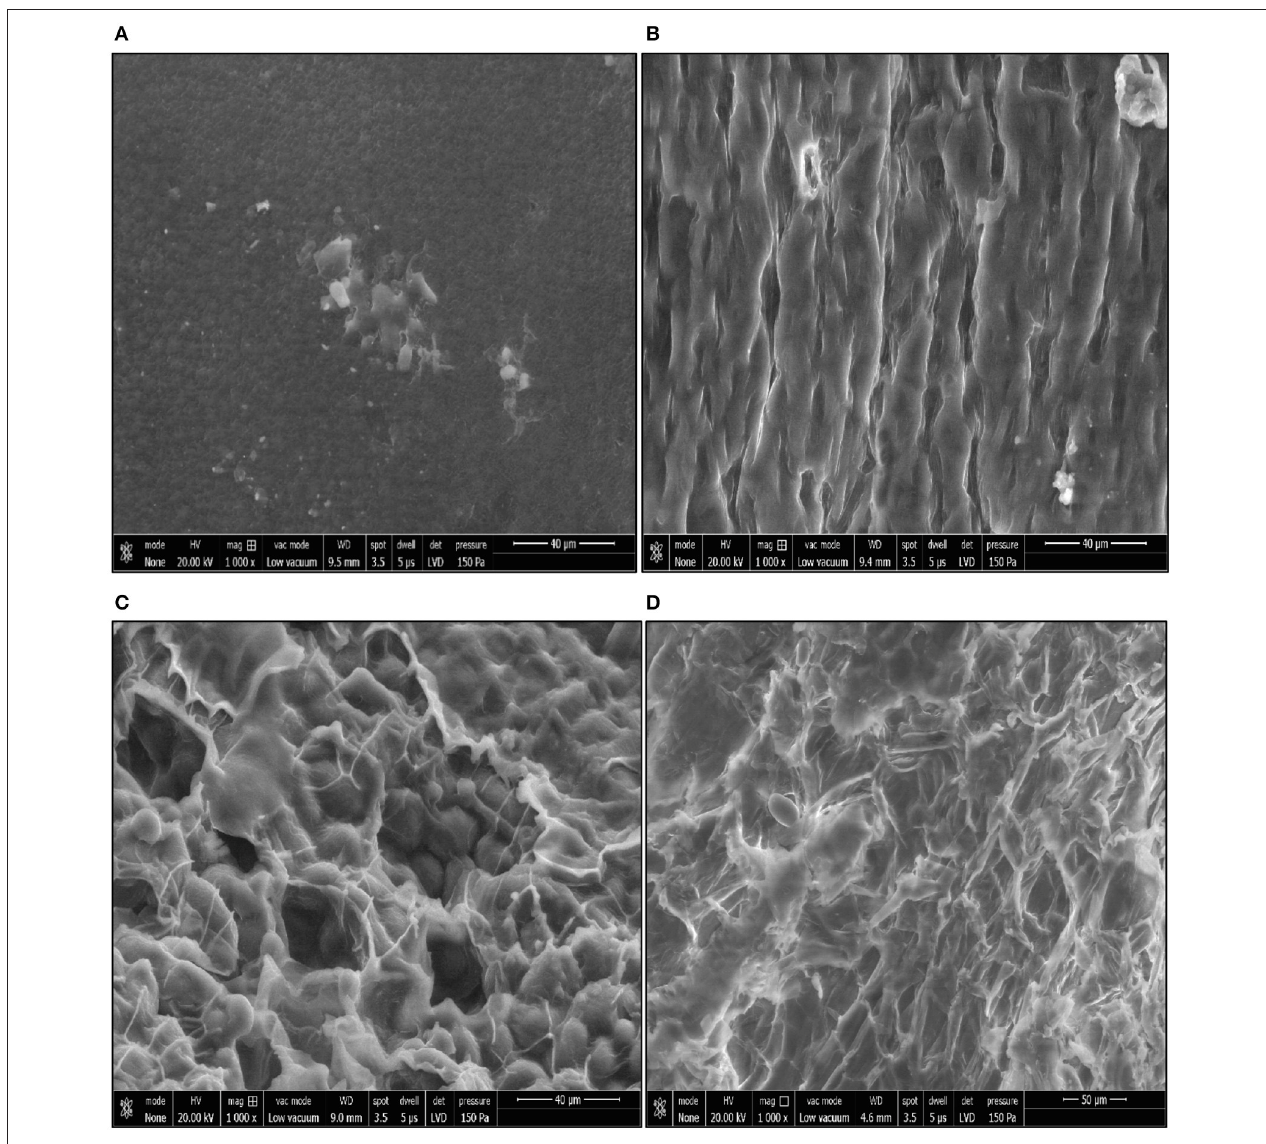
FIGURE 11 | The SEM images of (A) Untreated MBH, (B) MBH-30, (C) MBH-60, and (D)